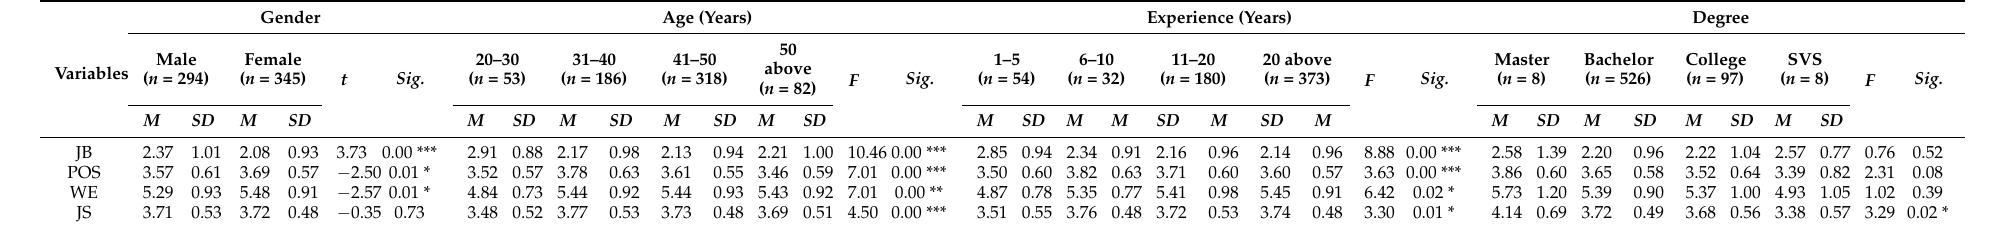
Table 3. Significant differences in gender, age, experience, and degree.